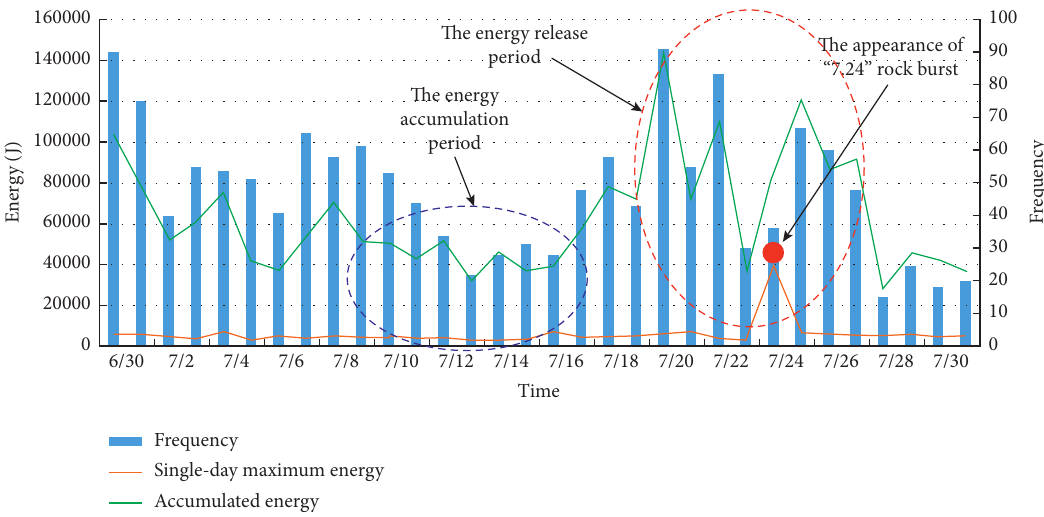
Figure 3: Diagram of microseismic energy and vibration frequency variations in 5305 working face.